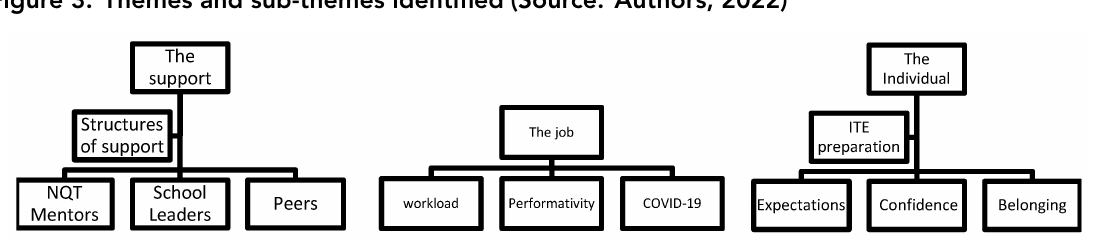
Figure 3. Themes and sub-themes identified (Source: Authors,